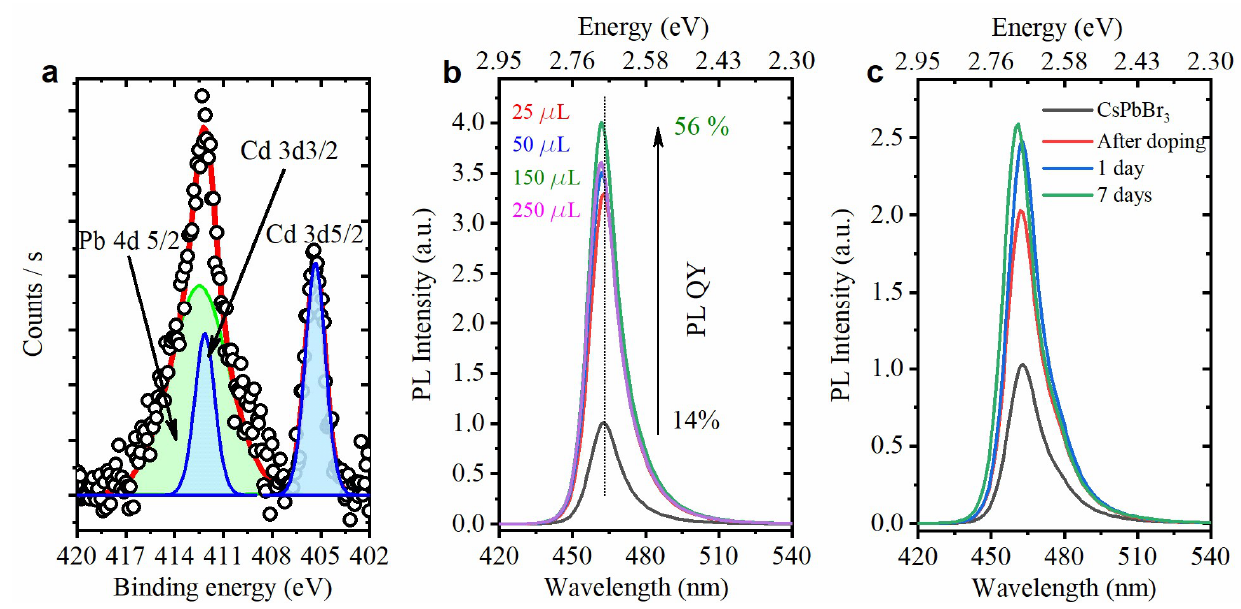
Figure 3. ( a ) XPS spectrum of Cd 3d peaks taken for the Cd 2+ -doped NPls with PL peak position at 445 nm. ( b ) PL spectra of NPls after adding various amounts of CdBr 2 with the increased amount of OlAm. ( c ) PL spectra of NPls after adding 20 µL of the precursor with octylamine before and after doping, as well as during seven days’ storage.